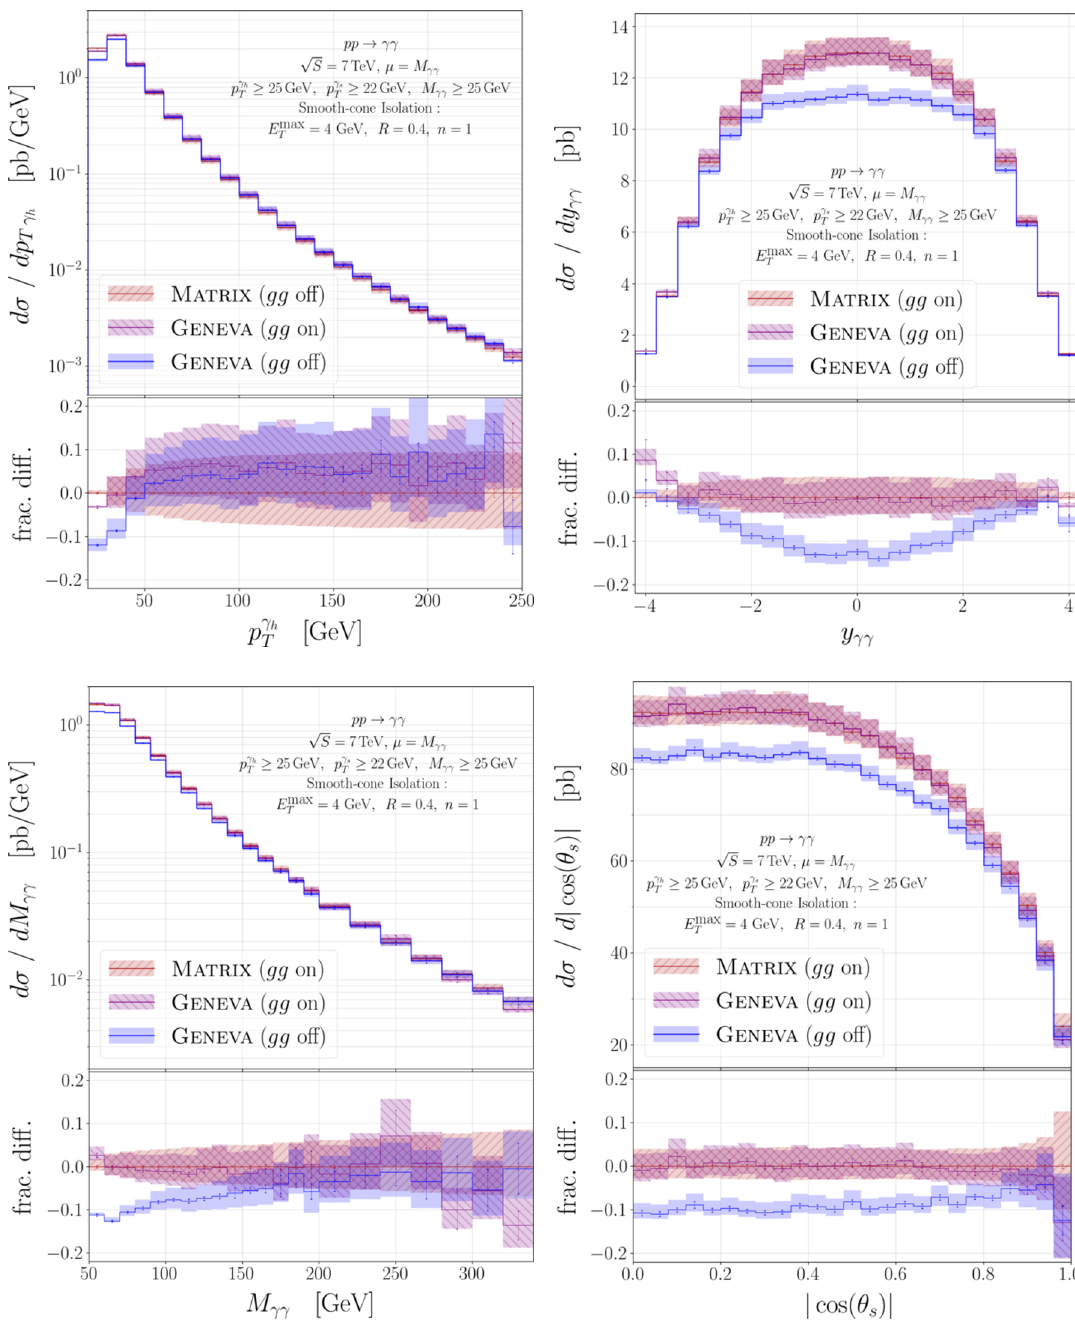
Figure 10 . Comparisons between Geneva and Matrix after the inclusion of the gg channel contribution. We also show the Geneva results before the inclusion of the gg